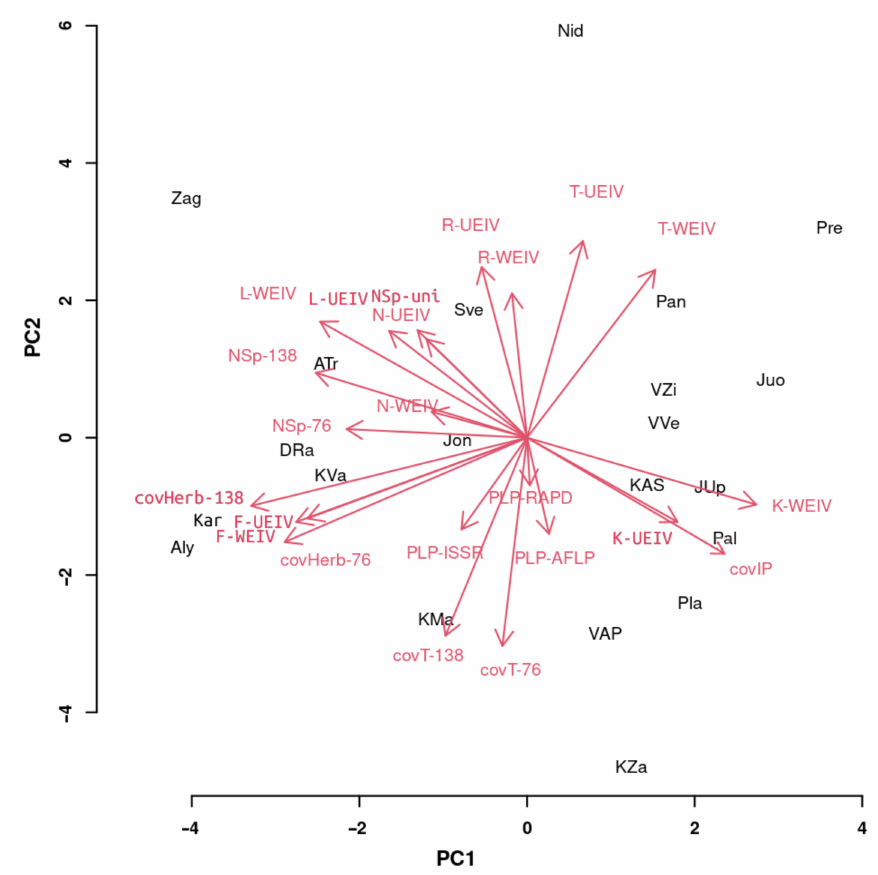
Figure 9. The analysis for the 1st two principal components (PC1 and PC2) of variation of small balsam ( Impatiens parviflora ) depending on genetic markers (PLP at AFLP loci, PLP at ISSR loci and PLP at RAPD loci), number and coverage by herbaceous plant species (NSp-138, NSp-76, cov-IP, covT-138, covT-76, covHerb-138, covHerb-76), and abiotic parameters (L, T, K, F, R, N) defined by EIVs (WEIVs and UEIVs). Three black letters denote populations and red arrows with letters denote